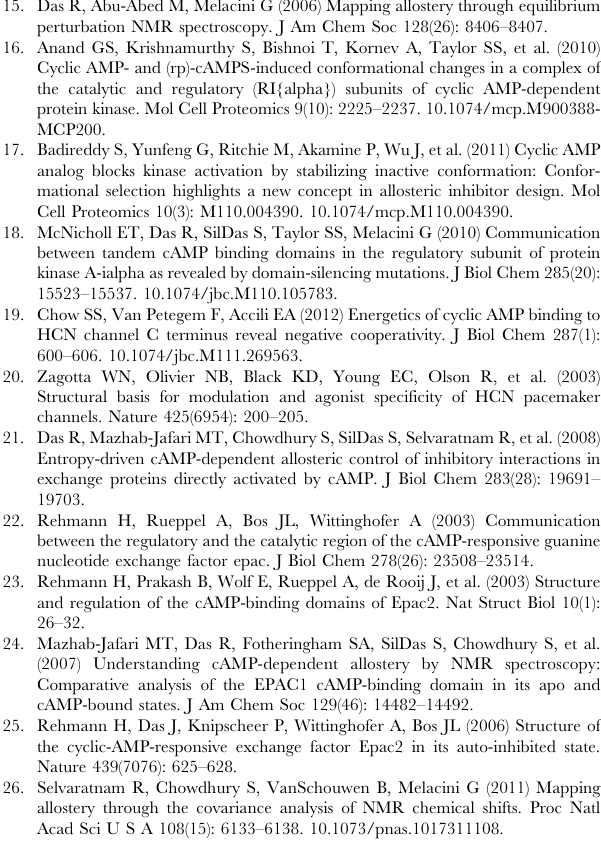
Figure S1 SVD analysis of the chemical shifts measured for the L273W(Apo) mutant and other Wt states depicted in the plot relative to the Rp-cAMPS-bound Wt. PC1 and PC2 are as explained in the main text. Blue diamonds are the loadings. (TIF) Figure S2 Dendrogram of the largest cluster of residues resulting from the agglomerative cluster analysis of the correlation matrix of Figure 5C. All nodes correspond to Pearson correlation coefficient $ 0.98. (TIF)